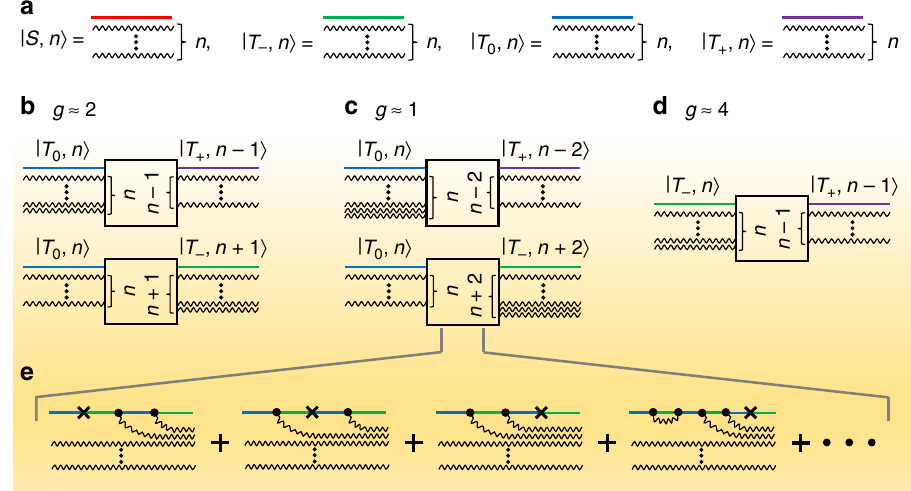
Fig. 1 Multiple-quantum transitions of spin pairs in the singlet-triplet basis. a The Floquet states describing the conductivity of an OLED under magnetic- resonant excitation are de fi ned by the photon number n (illustrated as wavy lines before and after the interaction) and the spin wavefunction (red, green, blue, purple). b The spin-½ resonance of the pair at an effective g-factor of g ≈ 2 corresponds to a raising or lowering of n . c , d Resonances also arise at g ≈ 1 and g ≈ 4 owing to two-photon and half- fi eld transitions, respectively. e Examples of diagrams of the two-photon transitions, where the vortices indicate the creation or annihilation of a photon ( • ) or spin scattering not involving a photon (×), e.g., owing to hyper fi ne or dipolar coupling. An in fi nite number of higher-order loops exists. Magnetoresistance on resonance is calculated by summation over all